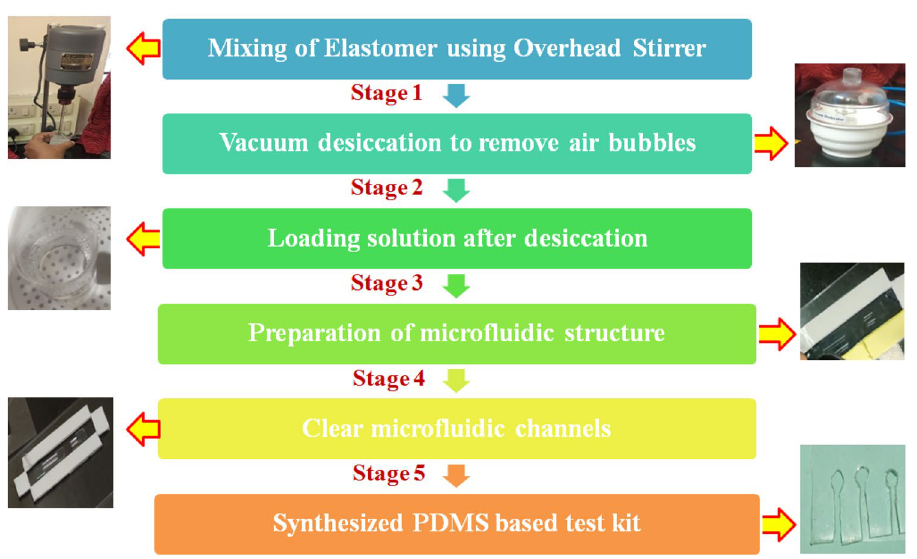
Figure 2. Process of development of PDMS-based test kit for the detection of E. coli in water quality